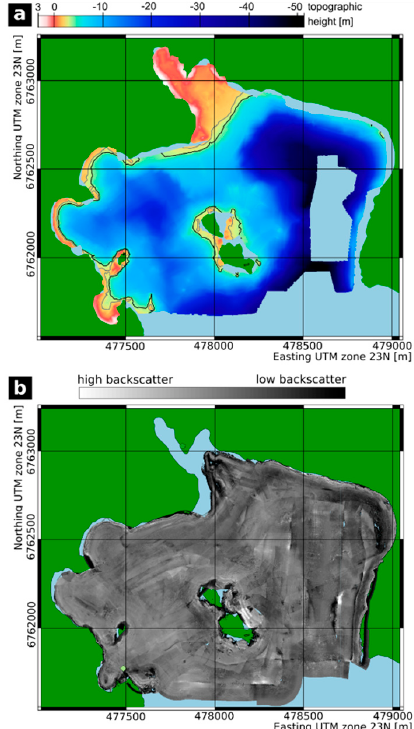
Figure 5. ( a ) Interpolated bathymetry of the Igaliku fjord end. The black and grey lines indicate the estimated low tide and high tide around the year 1000. At the northern end of the fjord, an extended embayment with depths of less than 2 m is recognized. ( b ) Complete side-scan mosaic of the whole Igaliku fjord end.